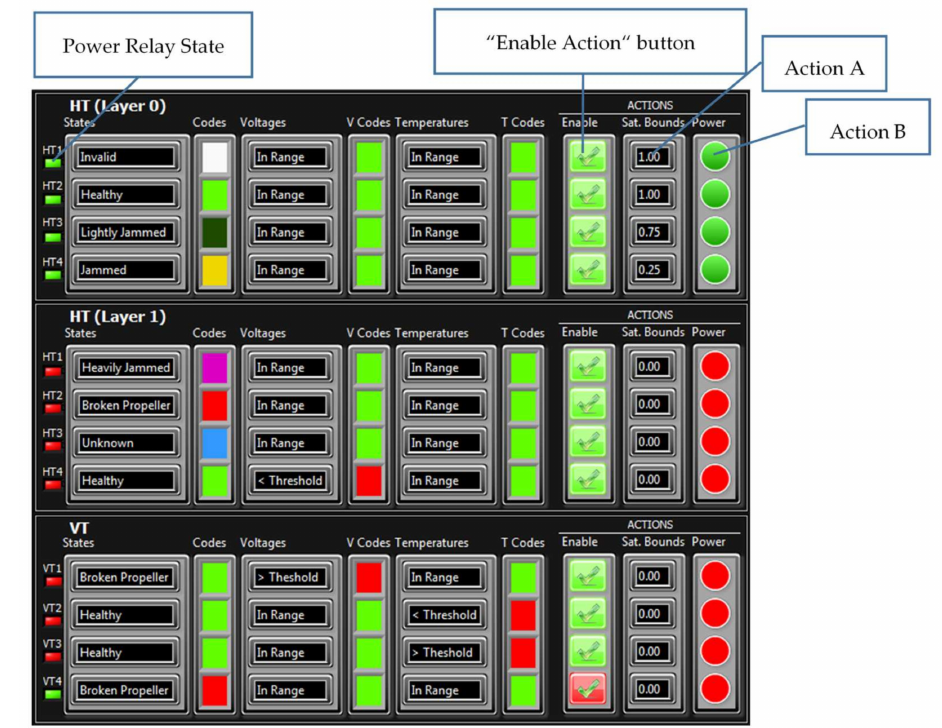
Figure 12. User Interface showing thruster FDI states and